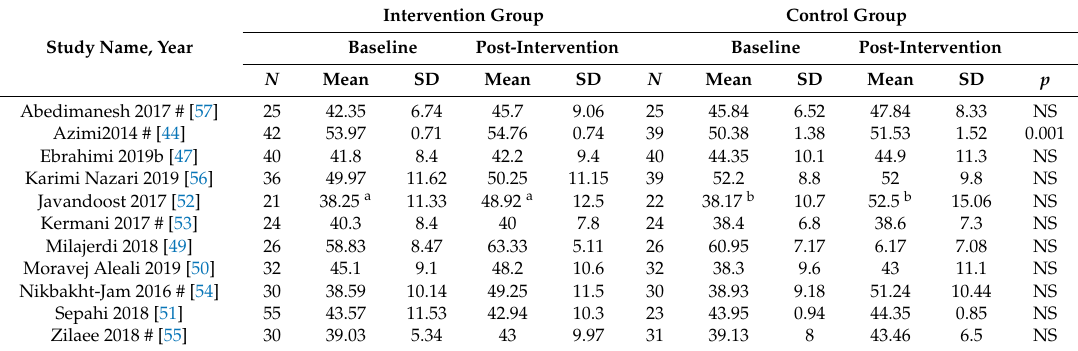
Table 6. Summary of findings for HDL cholesterol